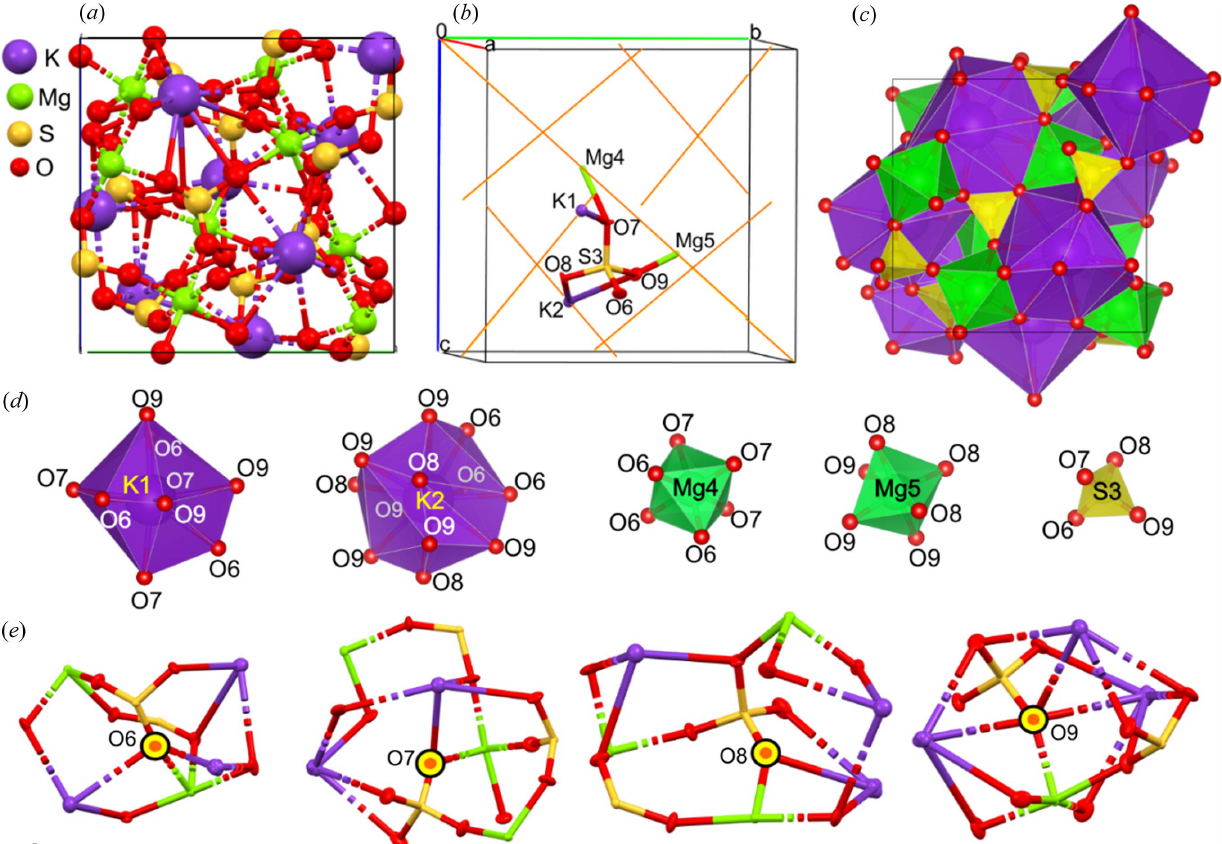
Figure 2 Langbeinite. ( a ) Atomic arrangement within the unit cell. ( b ) Atomic labels and ADP ellipsoids for atoms/ions defining the independent part of the unit cell (orange lines depict threefold axes). ( c ) Visualization of the polyhedral model of the langbeinite structure: SO 4 , MgO 6 and KO 12 polyhedra and the local neighbourhood of oxygen atoms/ions. The Wyckoff positions of K and Mg cations are a 3. Other ions are placed at general positions. ( d ) Separated polyhedral of particular ions. ( e ) Local neighbourhood of oxygen